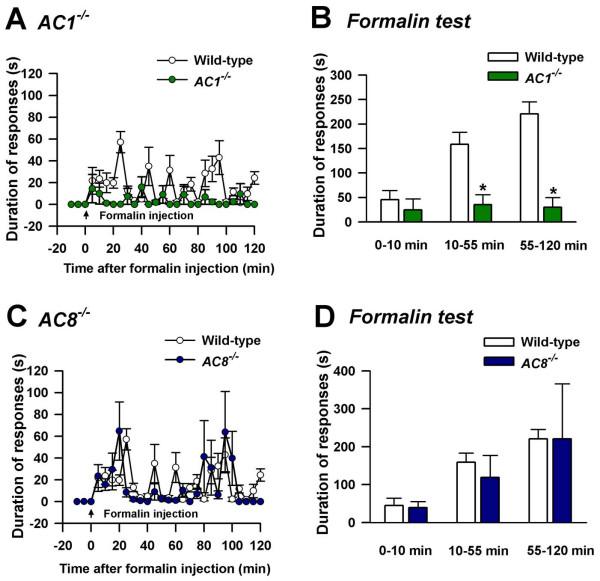
Behavioral nociceptive responses to intramuscular formalin in AC1 and AC8 single KO mice. Cumulative response for each 5 minutes time is plotted on y axis as duration of responses. A. Comparison of nociceptive responses to intramuscular formalin in wild-type and AC1 KO mice. Wild-type, n = 4 mice; AC1 KO, n = 8 mice. B. Data from experiment A is grouped as early, intermediate and late phases in comparison with wild-type mice. p < 0.05. *Significant difference from wild-type mice. C. Comparison of nociceptive responses to intramuscular formalin in wild-type and AC8 KO mice. Wild-type, n = 4 mice; AC8 KO, n = 8 mice. D. Data from experiment C is grouped as early, intermediate and late phases in comparison with wild-type mice.